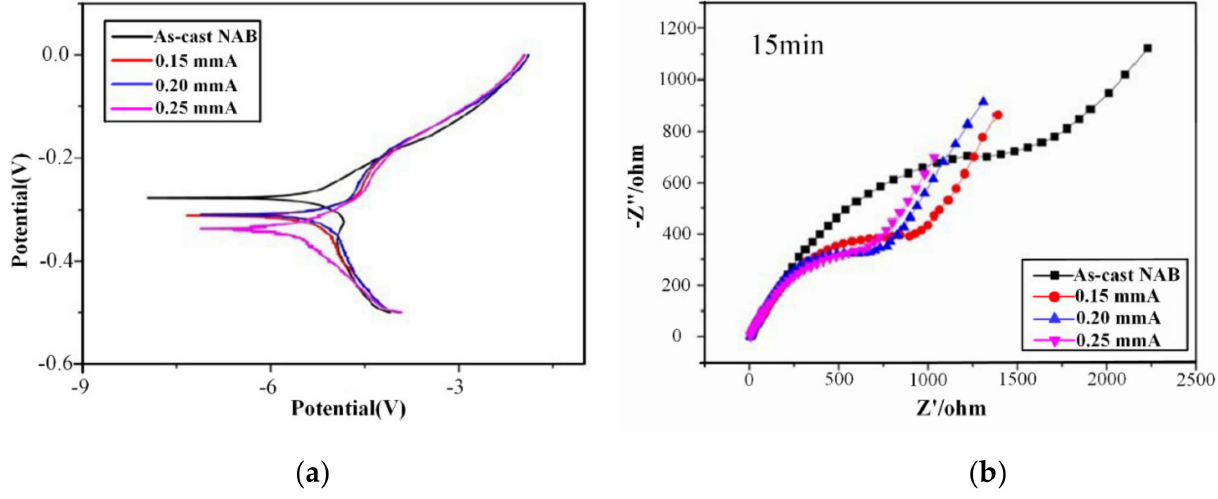
Figure 14. Polarization curve and Nyquist curve of as-cast NAB and samples with different shot peening intensity immersed in 3.5 % NaCl solution for 15 min. ( a ) Polarization curve; ( b ) Nyquist curve